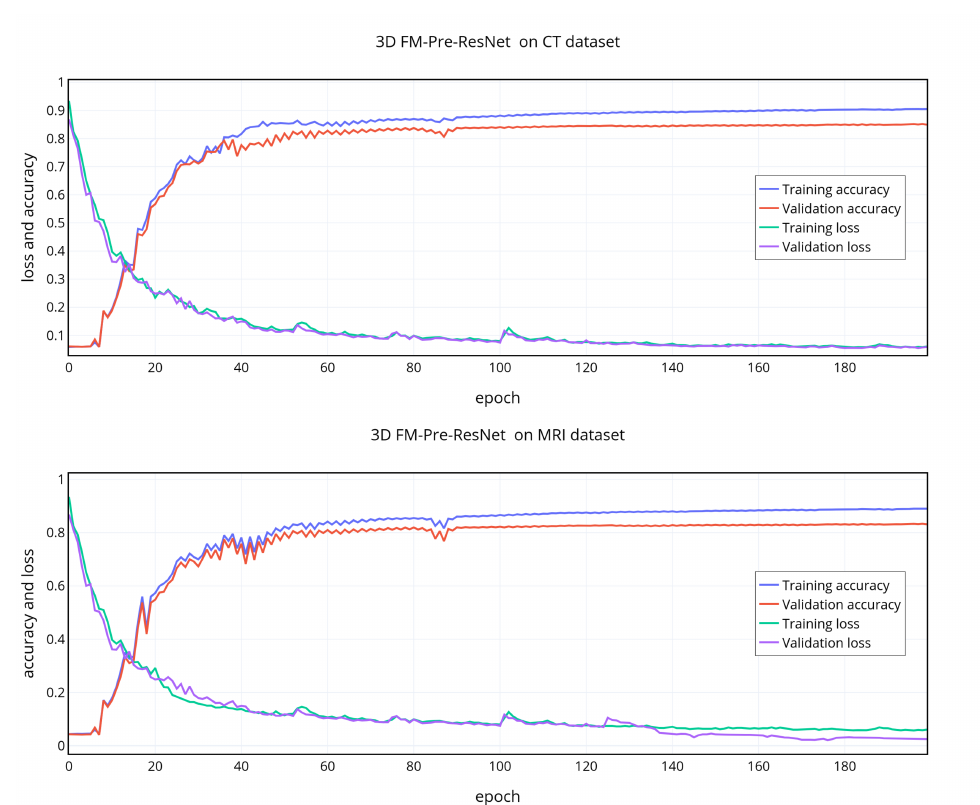
Figure 5. Training and validation accuracies and losses for 3D FM-Pre-ResNet + VAE network